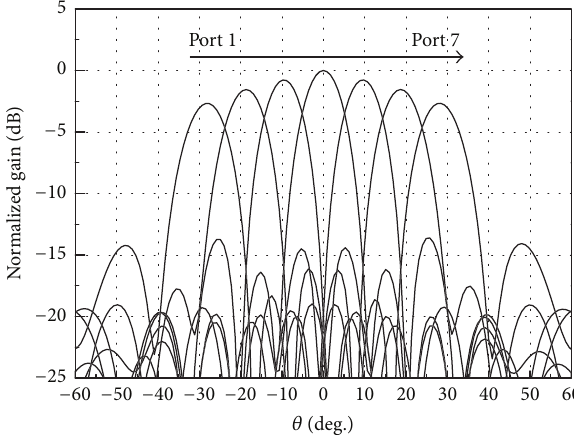
Figure 11: Radiation patterns of antenna array excited by amplitude and phase distributions of the Rotman lens at 14.25 GHz for H- polarization.